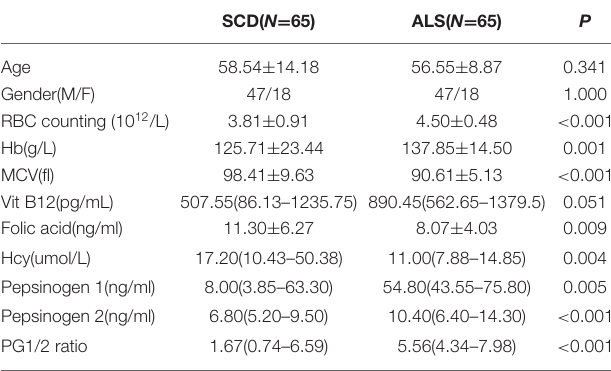
TABLE 2 | Demographics and Laboratory tests of SCD and ALS